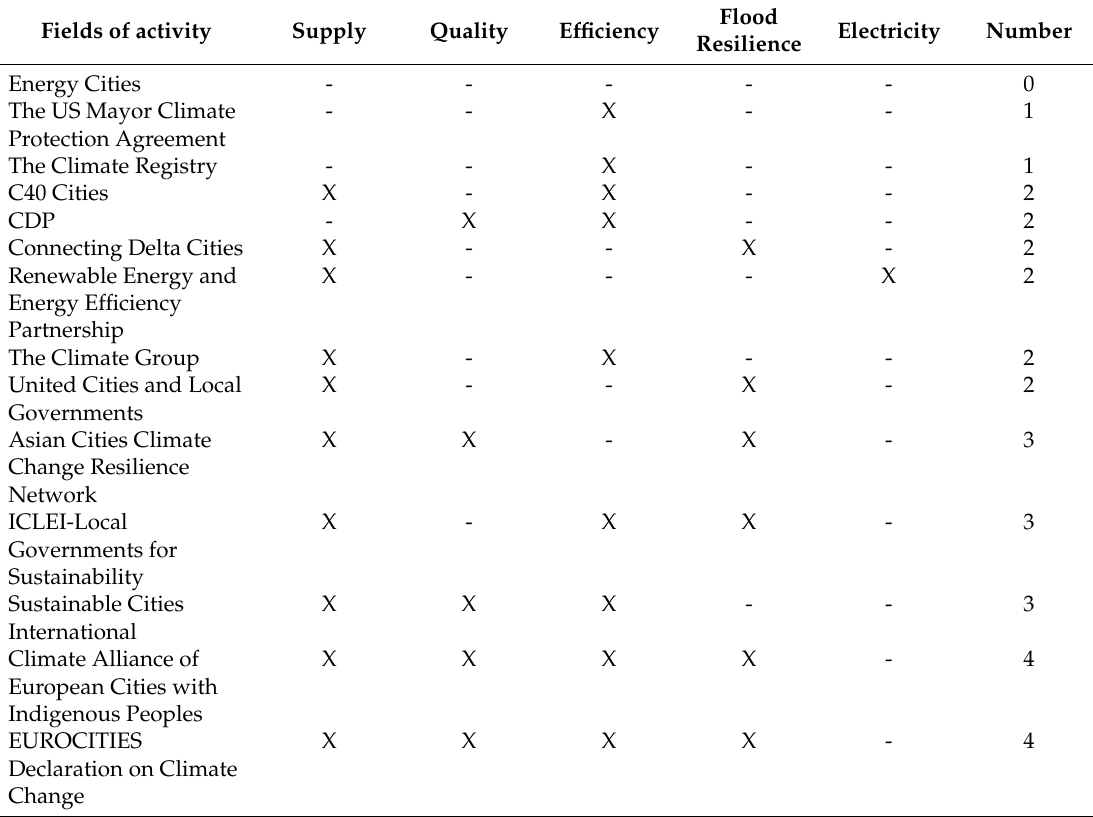
Table 2. Fields of activity of the city